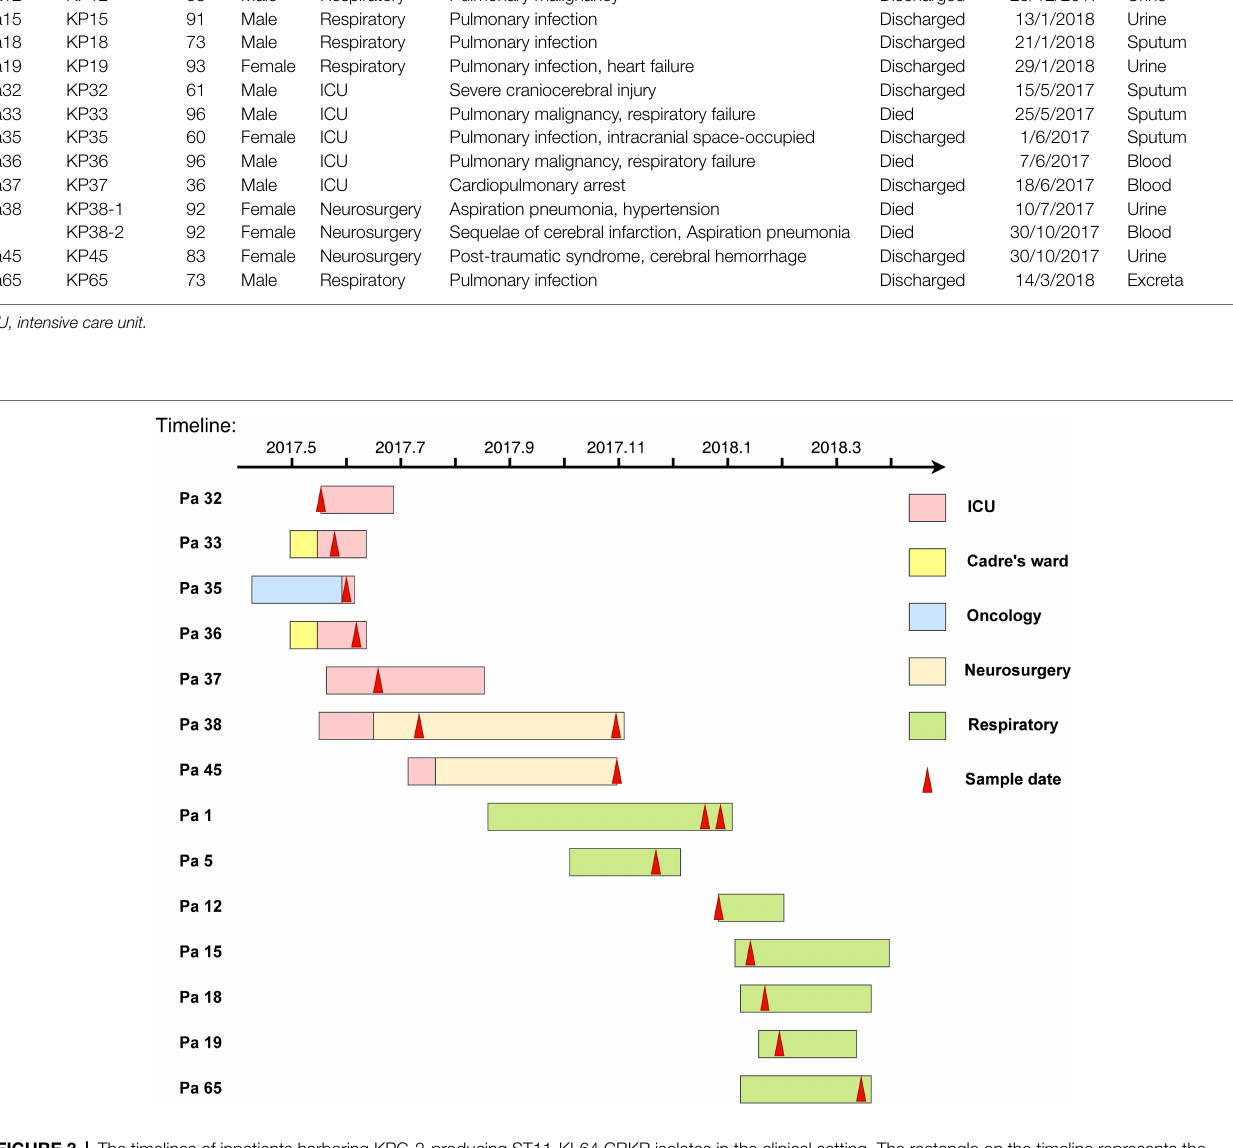
FIGURE 3 | The timelines of inpatients harboring KPC-2-producing ST11-KL64 CRKP isolates in the clinical setting. The rectangle on the timeline represents the admitting’s duration of the patients. Different wards are shown in different colors, and the red arrows indicate sampling